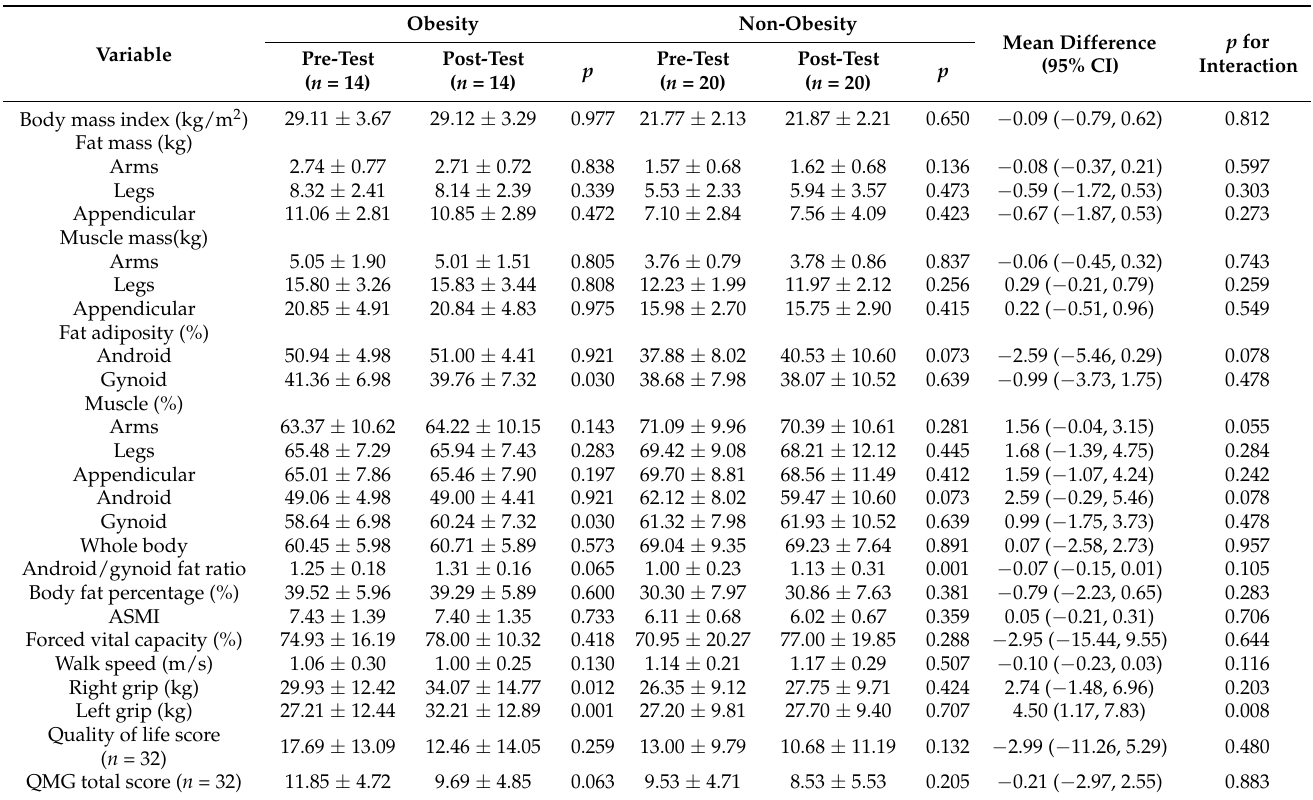
Table 5. Body composition of patients with MG before and after resistance training according to obesity and non-obesity.